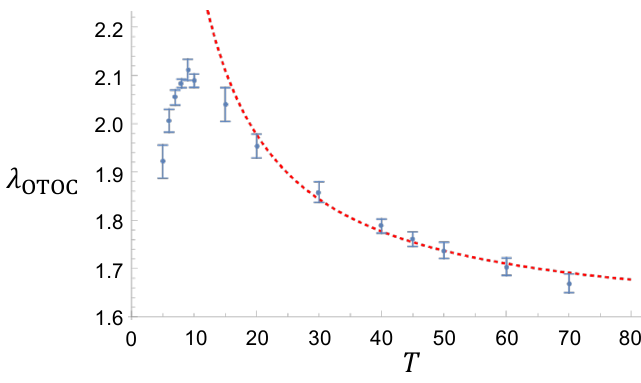
Figure 4 . The temperature dependence of the Lyapunov exponents λ OTOC of the thermal OTOCs. The bar represents the 95% confidence interval for the exponent. The dashed curve is the fitting function for the Lyapunov exponents obtained in the range 20 ≤ T ≤ 70 . figure 4. The bars represent the 95% confidence interval for the Lyapunov exponent at a given value of the